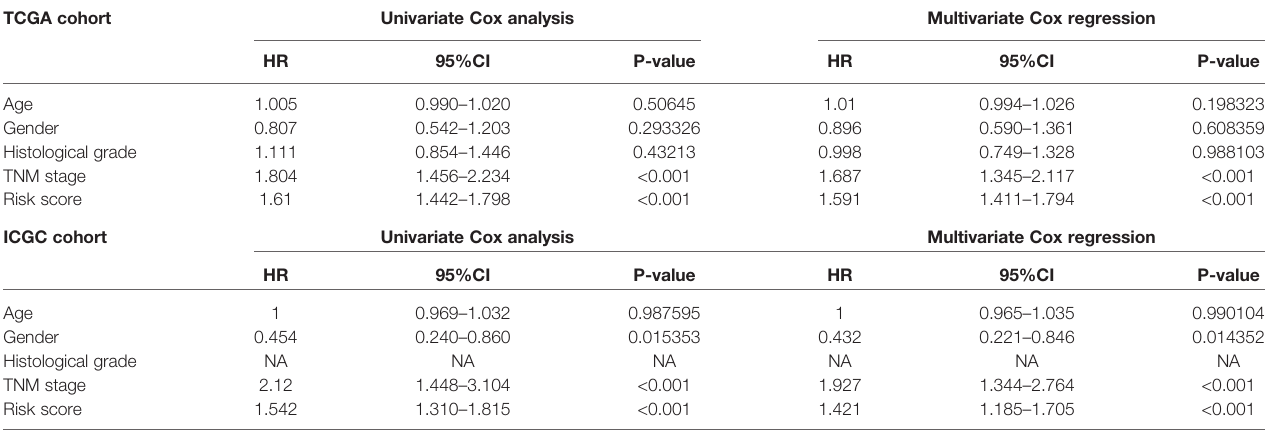
TABLE 3 | Univariate and multivariate analyses of different clinical characteristics in TCGA and ICGC cohorts. TCGA cohort Univariate Cox analysis Multivariate Cox regression